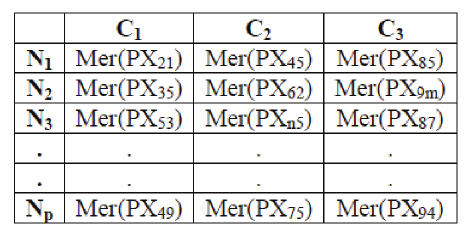
Fig.3. Sample initial